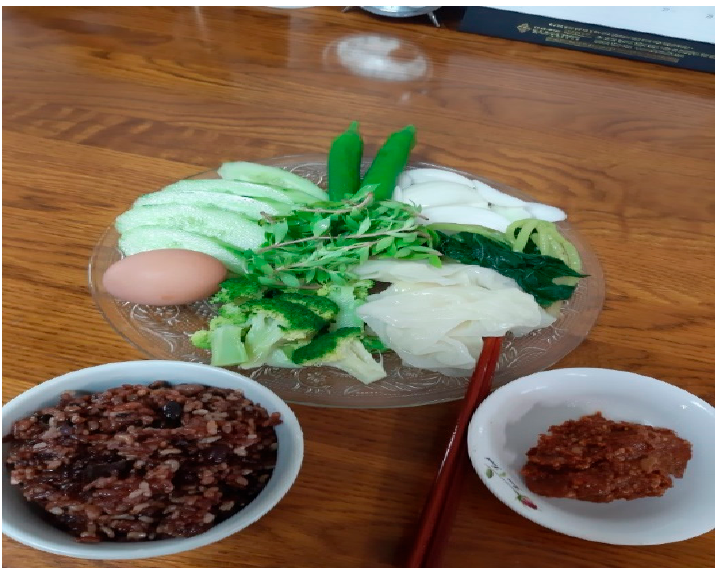
Figure 3. Weight management facilitators for breast cancer patients.